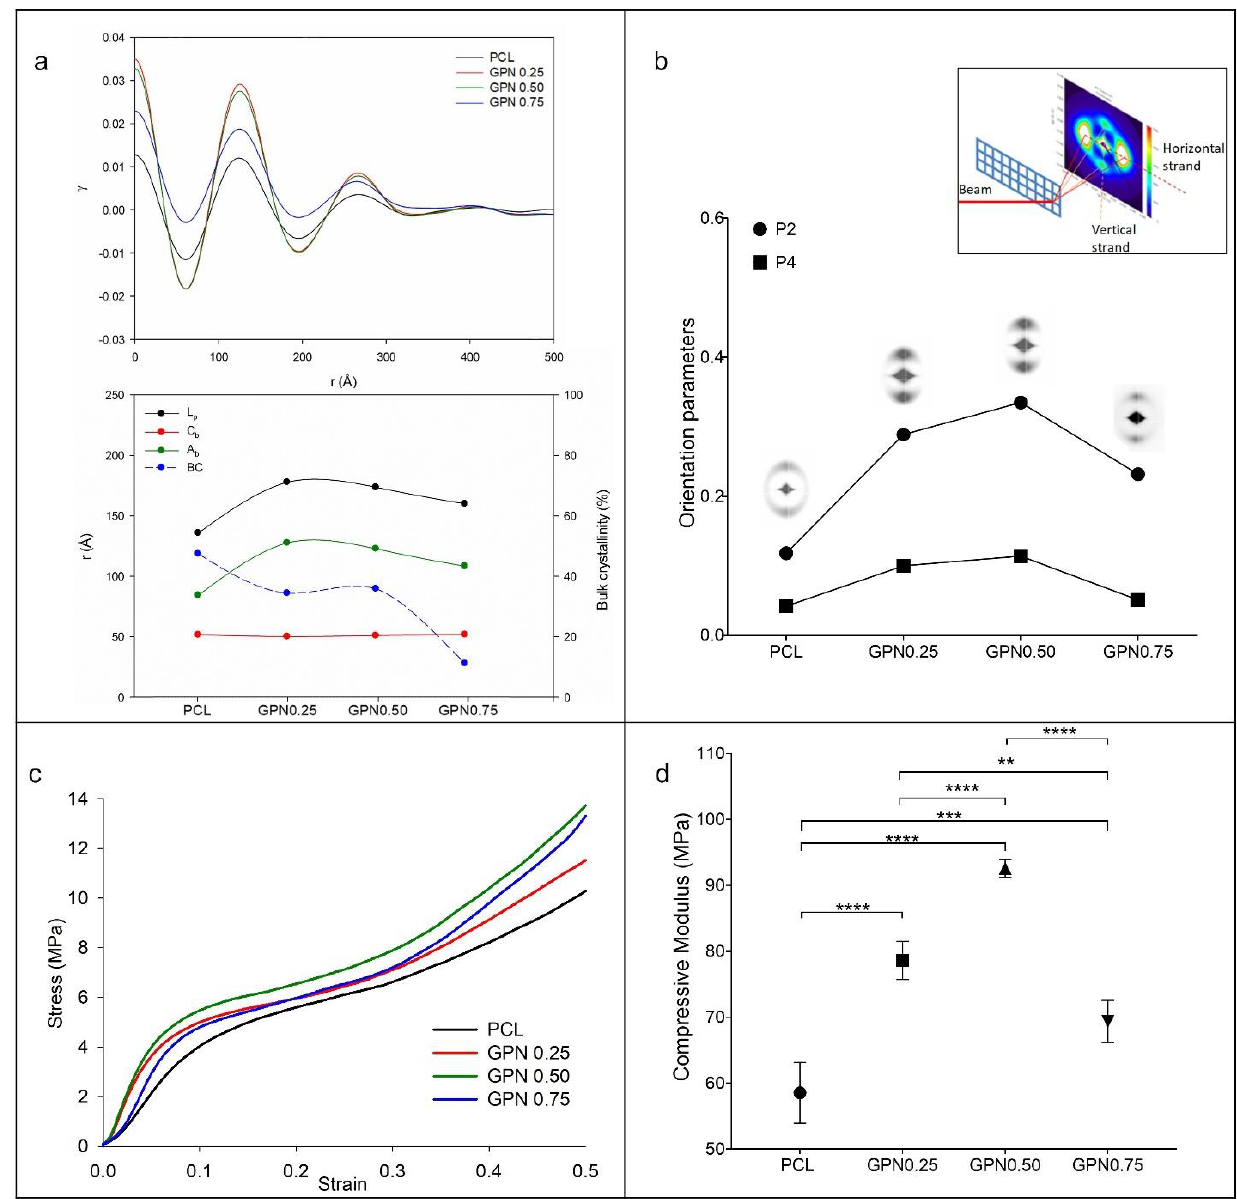
Figure 4. SAXS (upper line) and mechanical properties (bottom line): ( a ) Correlation function obtained from scattering curves (left), and variation in the values of long period (L p ), crystalline (C b ), and amorphous layer (A b ) thicknesses and bulk crystallinity (BC) extracted from correlation functions with GPN content (right); ( b ) 2D SAXS pattern and orientation parameters <P2> and <P4> of PCL filaments with different contents on GPN; ( c ) PCL and PCL/GPN scaffold stress–strain curves under compression; ( d ) compressive modulus of 3D PCL and PCL/GPN scaffolds. Statistical differ- ences: ** p < 0.01; *** p < 0.001; **** p < 0.0001.